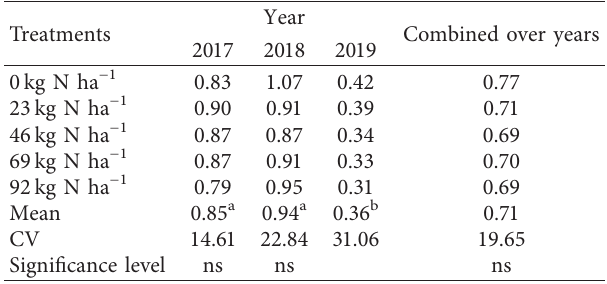
Table 2: Mean leaf to stem ratio of Chloris gayana grass in response to different N fertilizer